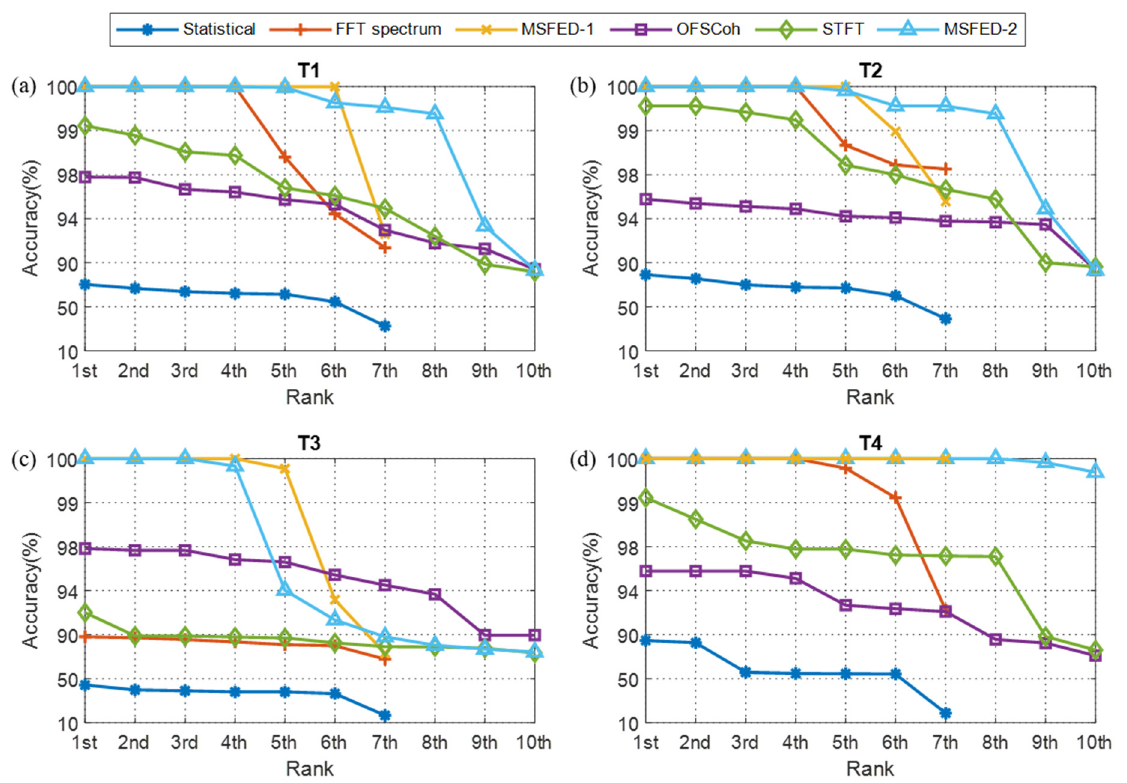
Figure 5. Diagnostic accuracy of different features and models on four tasks: ( a ) T1, ( b ) T2, ( c ) T3, and ( d ) and ( d ) T4.